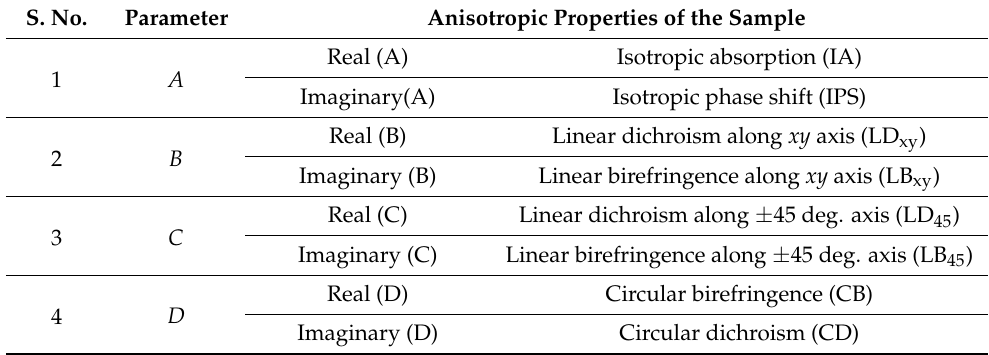
Table 1. Anisotropic properties using the algebraic method for Jones matrix decomposition. S.